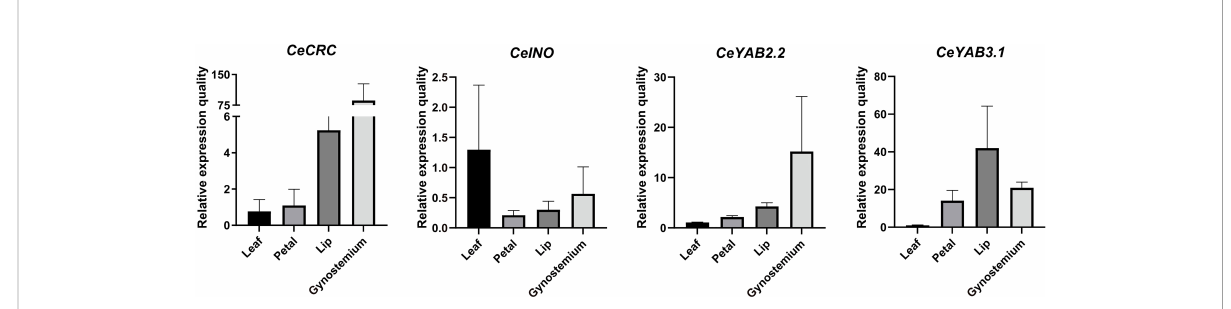
FIGURE 6 Relative expression patterns of YABBY genes in C. ensifolium . Raw data are listed in Supplementary Tables S6 and